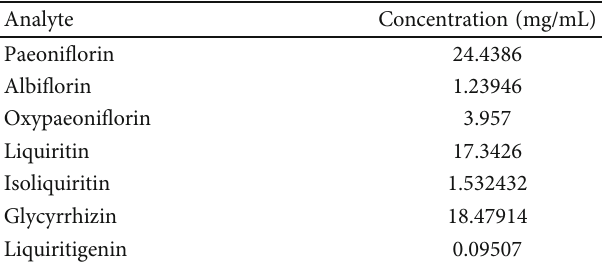
Table 3: The contents of the seven analytes in SGD.